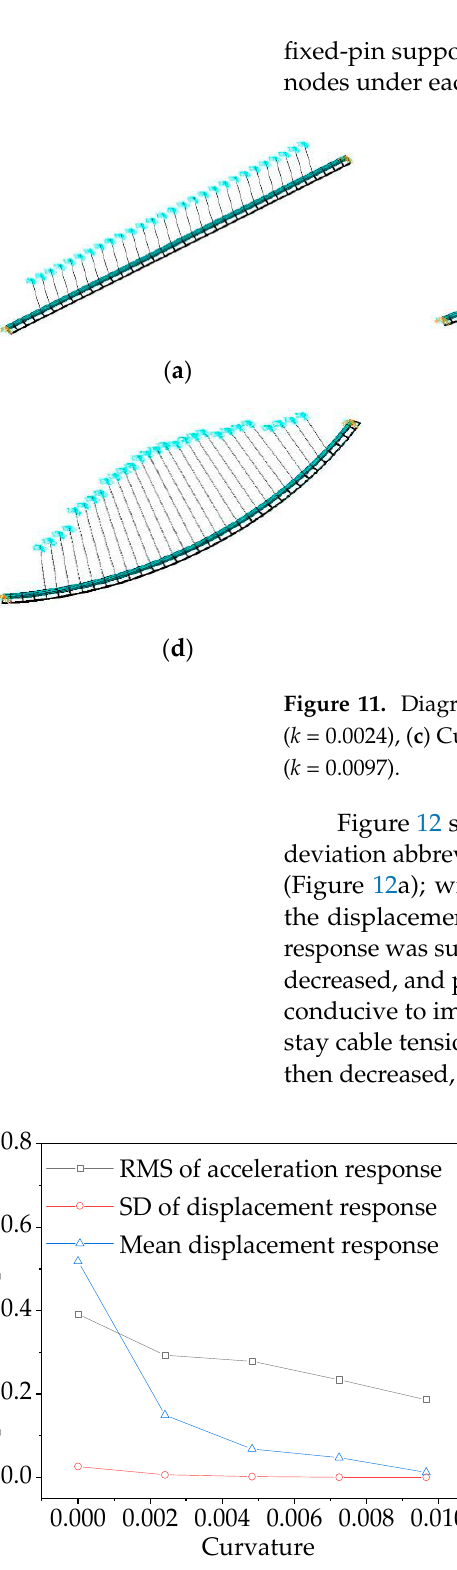
Figure 12. Wind-induced vibration response analysis of CBUSB with curvature transform. ( a ) Along-wind wind-induced vibration response of bridge, ( b ) Stayed cable tension response.